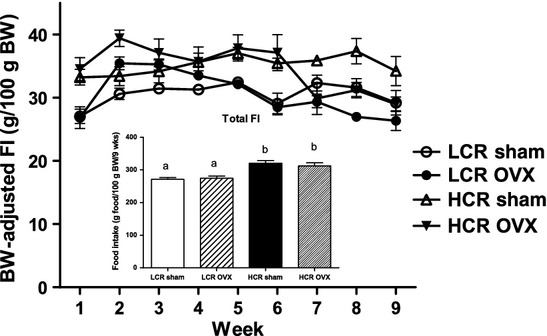
HCR rats consume more energy per gram of body weight than LCR irrespective of OVX. Weekly body weight adjusted food intake (line graph); total body weight-adjusted food intake (g food/100 g BW; inset) in LCR and HCR rats with and without OVX 9 n = 8–10/group). HCR rats consumed more food per gram body weight than LCR animals regardless of OVX. ANOVA followed by Tukey post hoc analysis. Unlike letters are significantly different; P < 0.01.